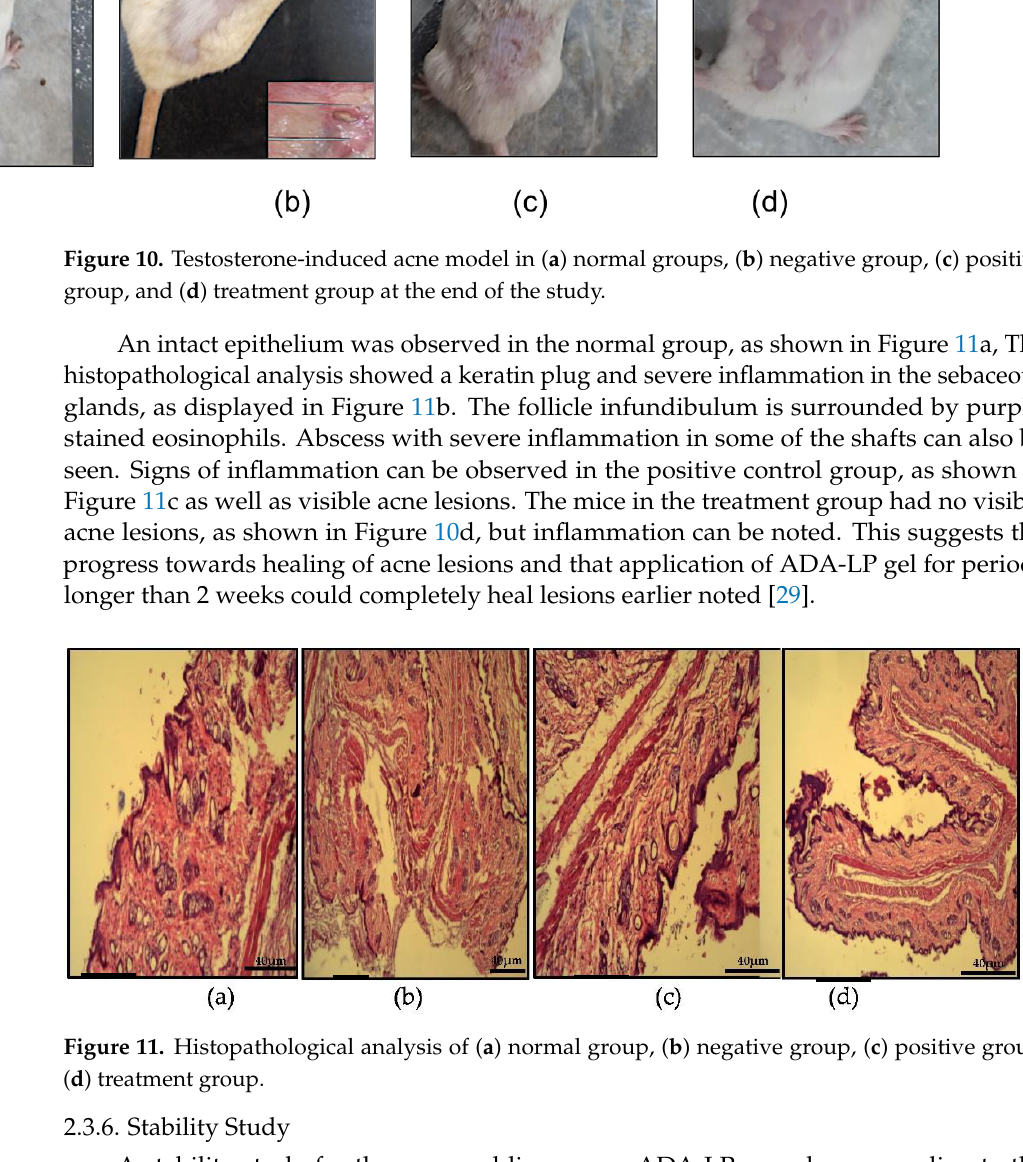
Figure 9. Testosterone-induced acne model in ( a ) normal group, ( b ) negative group, ( c ) positive group, and ( d ) treatment group after 3 weeks .